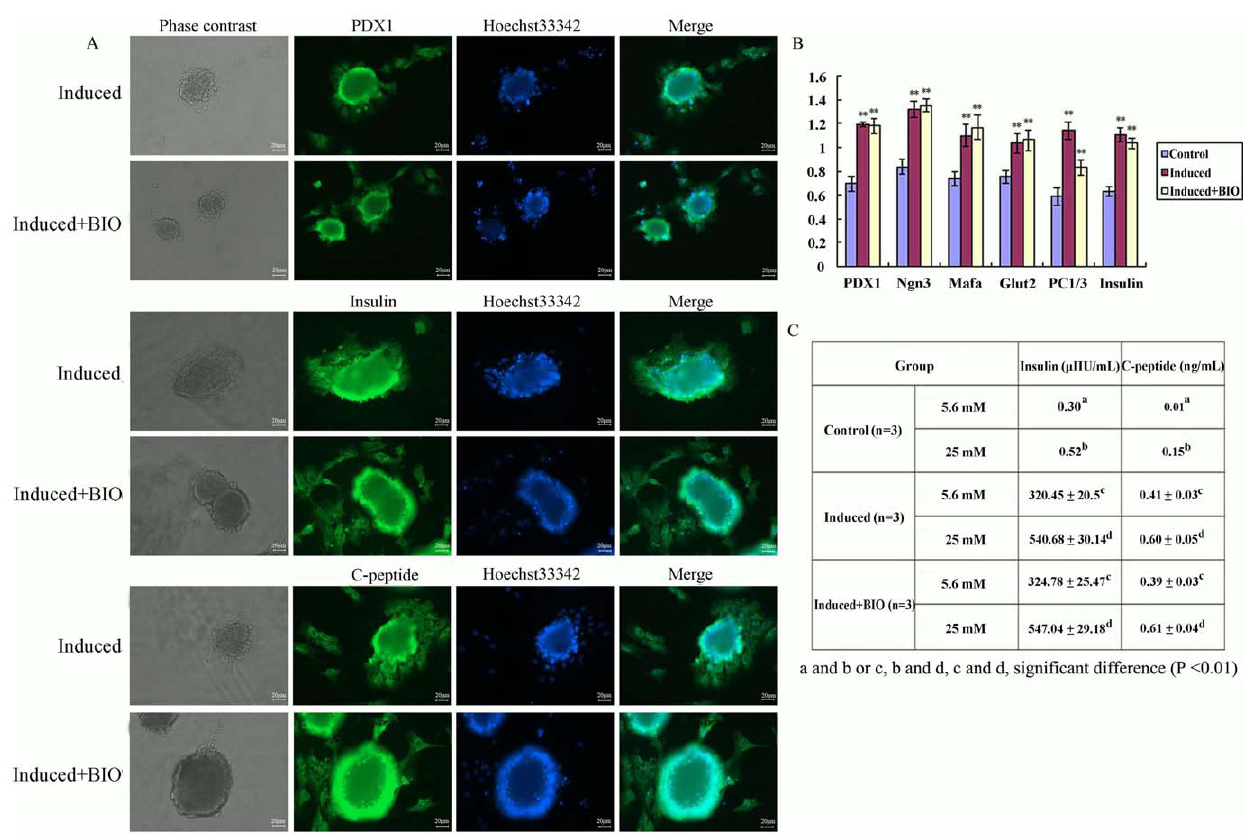
Figure 6. Potential differentiation of islet cells. A, The induced clusters treated with BIO or not were transferred into plates and stained positive for PDX1, C-peptide and insulin analysed by immunofluorescent staining; B, The specific markers of pancreatic islets including PDX1, Ngn3, Mafa, Glut2, PC1/3 and Insulin expressed in the iPMSCs treated with BIO or not by QRT-PCR; C, Glucose-stimulated insulin release and insulin content analysis. Bar=20 m m, **P , 0.01.